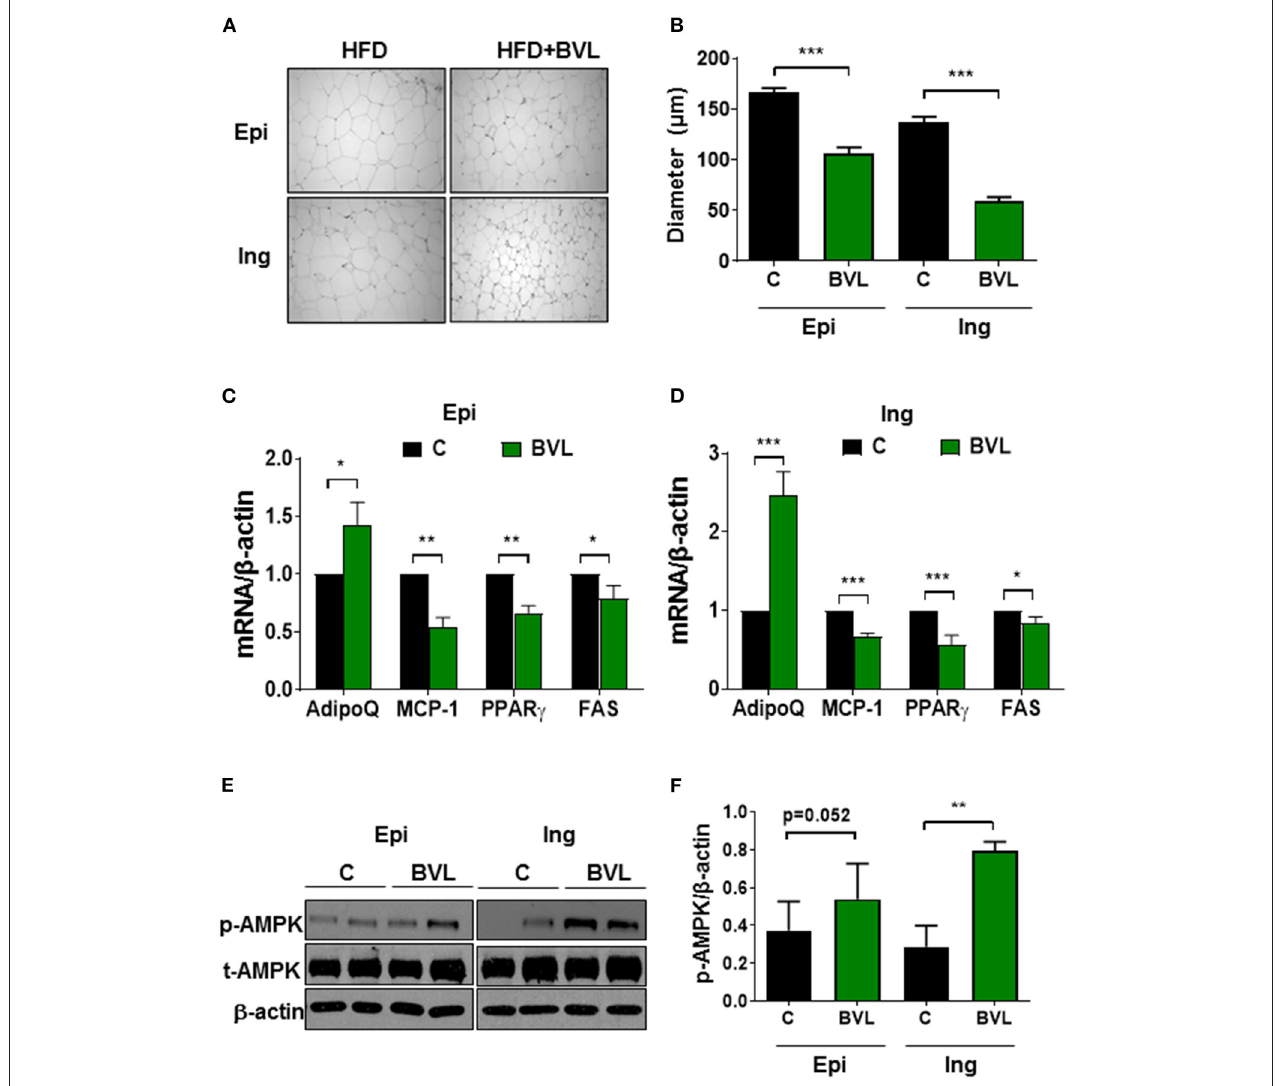
FIGURE 2 | BVL attenuates adipocyte expansion and inflammation in adipose tissue. (A) The adipocyte size in epididymal (Epi) and inguinal (Ing) fat pad was shown in this representative image and the quantification of adipocyte size was shown in (B) . The gene expressions in Epi (C) and Ing (D) were performed using qPCR. The representative image of immunoblotting (E) and quantification of p-AMPK expression (F) in Ing and Epi were measured using software Image J. The values were presented using mean ± SEM ( n = 3–4). The experiment was repeated twice with similar results and to avoid the huge variation, the data shown here was from the second experiment. * p < 0.05, ** p < 0.01, *** p < 0.001.